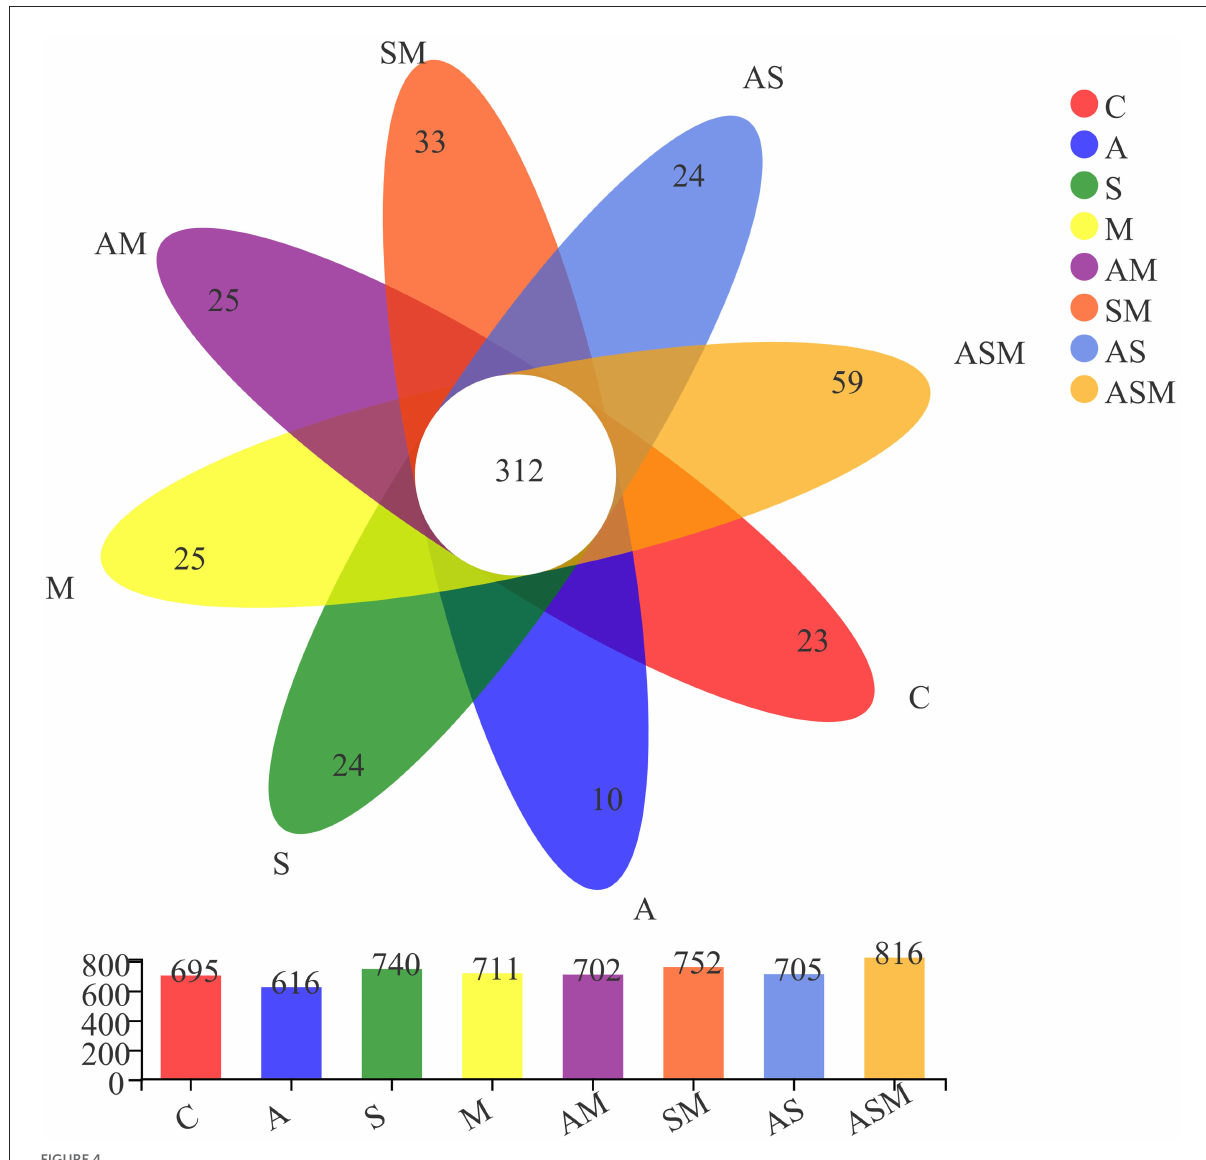
FIGURE4 Venn diagram displaying the overlap in fungal OUTs composition of A. adsurgens under different fungal inoculation treatments. C, non-inoculated control; A, inoculation with Alternaria chlamydospora ; S, inoculation with Sarocladium kiliense ; M, inoculation with Monosporascus sp.; AS, co-inoculation of Alternaria chlamydospora and Sarocladium kiliense ; AM, co-inoculation of Alternaria chlamydospora and Monosporascus sp.; SM, co-inoculation of Sarocladium kiliense and Monosporascus sp.; ASM, combination inoculation of the three